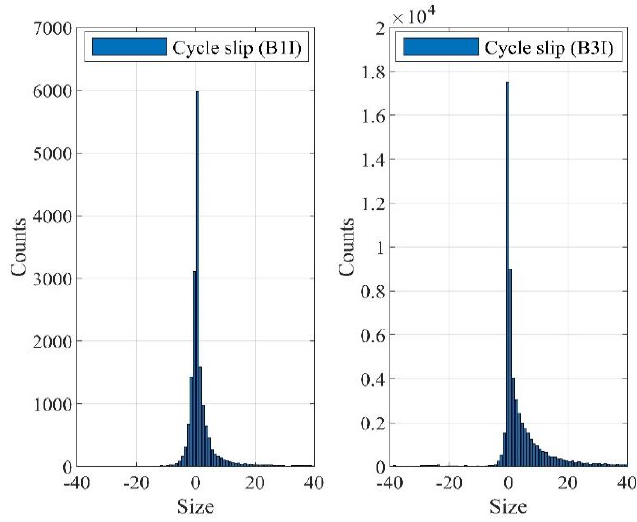
Figure 9. The histogram of cycle slips at B1I and B3I.